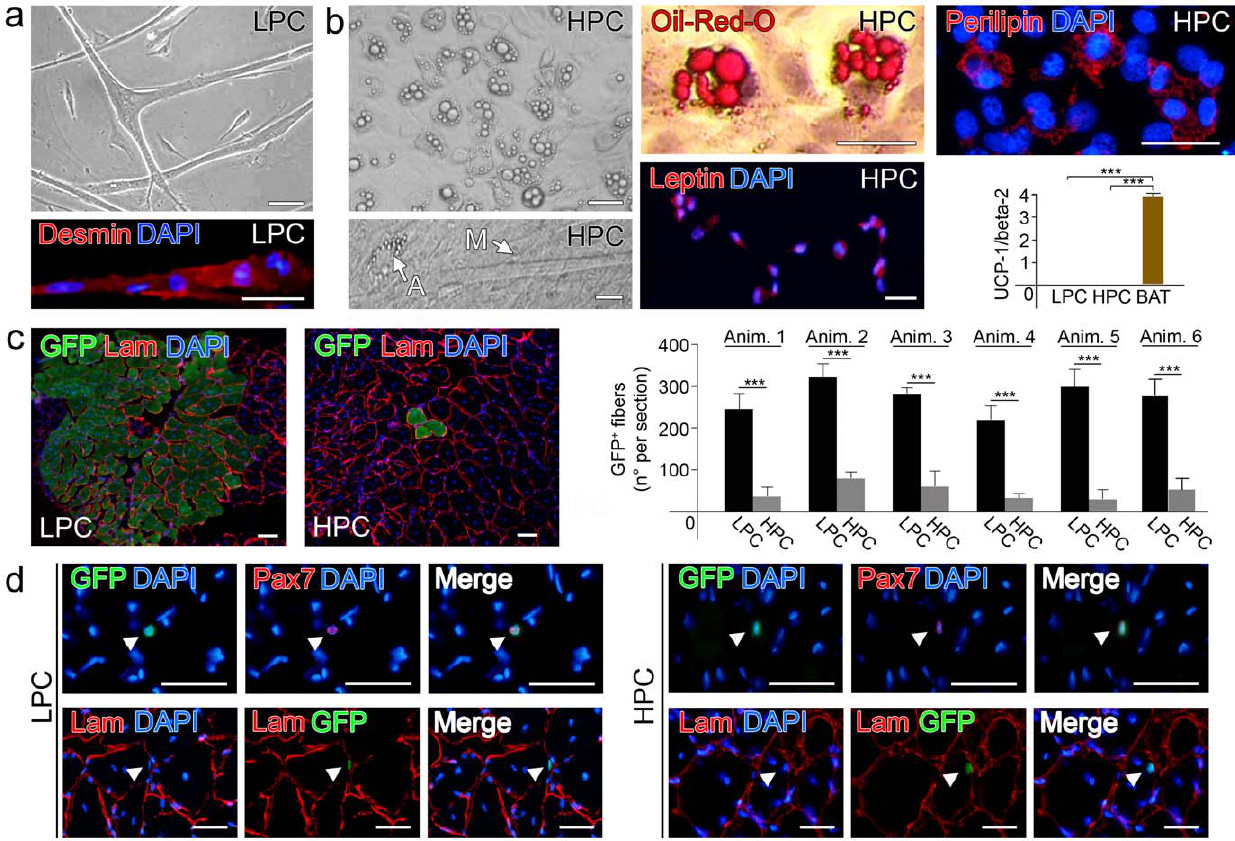
Figure 3. Invitro and invivo differentiation potential of subpopulations of SCs. (a) Spontaneous differentiation potential of LPC and HPC in high serum medium: LPC give rise to mature myotubes (top), as visible through phase contrast microscopy, that were positively immunostained for desmin (bottom, bar=100 m m). (b) HPC give spontaneously rise to adipocytes, well visible through phase contrast microscopy (top left), and a small amount of myotubes (bottom left). Lipid droplets are marked through Oil-Red-O staining (top center) and immunostaining for perilipin (top right) (bar=100 m m). Immunostaining for leptin on HPC (bottom center). Real-time PCR for mitochondrial uncoupler protein UCP-1 on LPC and HPC, compared with brown adipose tissue (BAT) (***p , 0.001; bottom right). (c) Epifluorescence analysis for GFP and immunostaining for laminin on muscle sections injected with LPC (left) and HPC (center). On the right is reported a diagram indicating for each of six animals treated the amount of GFP + fibers per section of muscle injected with LPC and HPC (mean 6 s.d.,***p , 0.001). (d) Immunofluorescence analysis for Pax7 and epifluorescence for GFP, merged with DAPI on sections of muscles treated with LPC (top panel, left) and HPC (top panel, right). Epifluorescence for GFP and immunostaining for laminin, merged with DAPI, on sections of muscles treated with LPC (lower panel left) and HPC (lower panel right) (bar=100 m m).